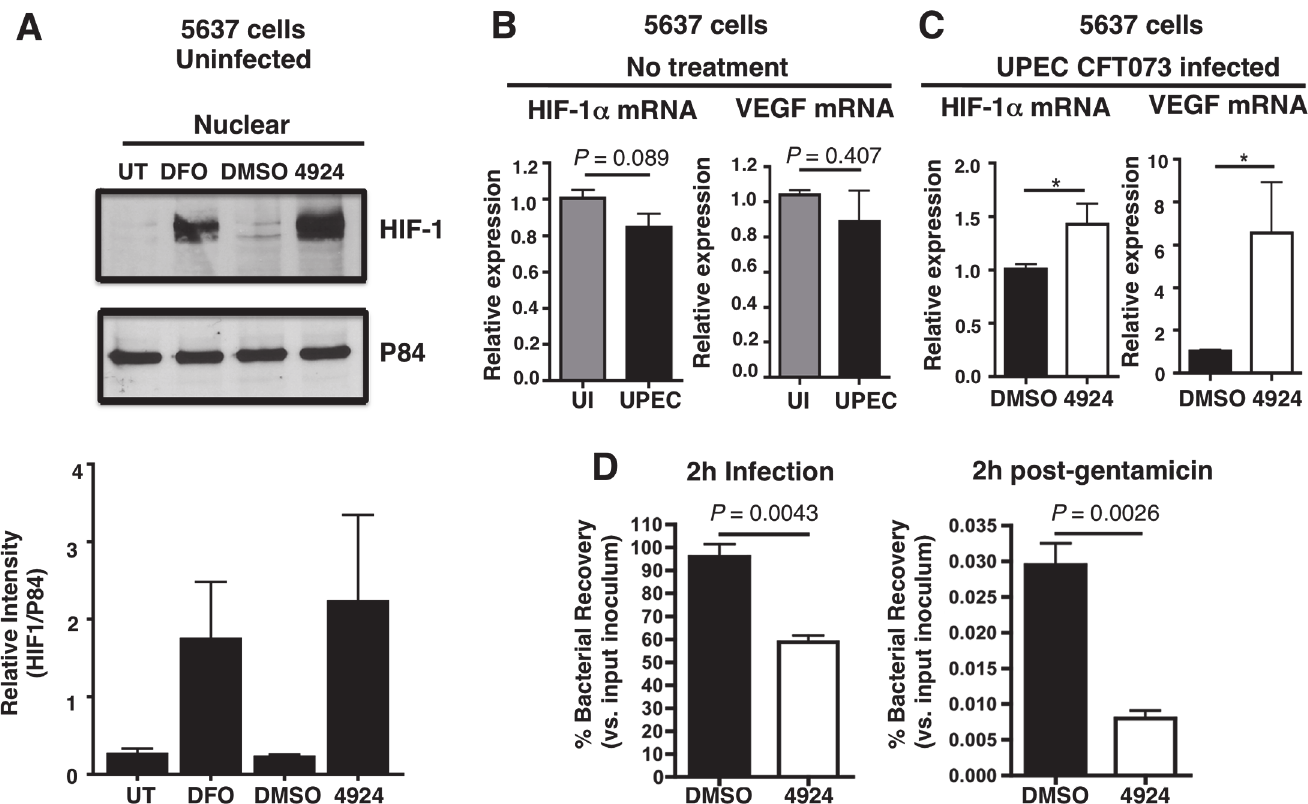
Fig 1. AKB-4924 stabilizes HIF-1 α protein and reduces UPEC-mediated infection of cultured human uroepithelial cells. ( A ) Western blot illustrating expression of HIF-1 α (120 kDa) in the nuclear fraction of uninfected human uroepithelial cell line 5637 left untreated (UT), or treated with DMSO (negative control), DFO (desferrioxamine mesylate; positive control) or AKB-4924 for 2 h. Nuclear matrix protein P84 was used as loading control. Bar graph shows relative intensity of protein bands from repeated experiments (n = 2). ( B ) Real-time qPCR showing relative HIF-1 α and VEGF mRNA expression in uninfected (UI) or UPEC CFT073 infected (2 h) 5637 cells without treatment, or ( C ) DMSO (mock treatment and 4924 pre-treated cells followed by UPEC infection (n = 10) ( D ) Bacterial counts from 2 h DMSO or AKB-4924 treated 5637 cells followed by 2 h infection with UPEC CFT073 to measure total bacteria, or 2 h infection with additional 2 h gentamicin (100 μ g/mL) treatment to measure intracellular bacteria (n = 3 per group). Shown as mean +/- S.E.M., * P < 0.05, Student ’ s unpaired t-test. Results are pooled from three independent